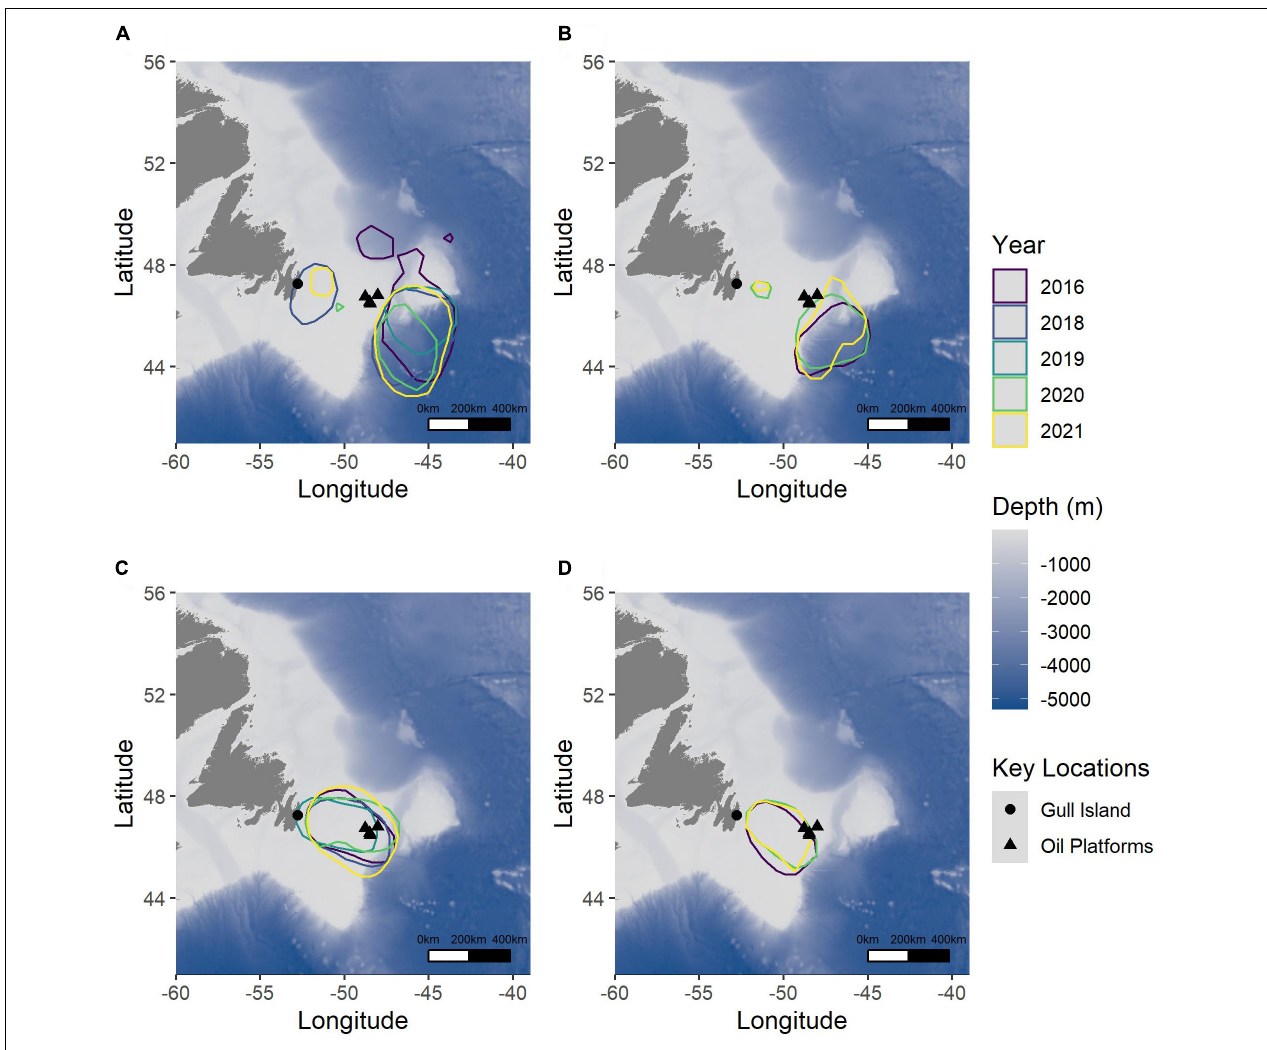
FIGURE 6 | 50% Utilization Distributions of Leach’s Storm-Petrels breeding on Gull Island, Witless Bay, Newfoundland and Labrador, Canada, in 2016–2021 for foraging areas (intensive and extensive) during (A) incubation and (B) chick-rearing, showing reduced foraging areas which are closer to the edge of the Grand Bank during chick-rearing. Transiting areas were not modified between (C) incubation and (D) chick-rearing. The large black triangles represent the oil platforms, and the large black circle represents Gull Island. The bathymetry is represented where darker blue indicates deeper water.